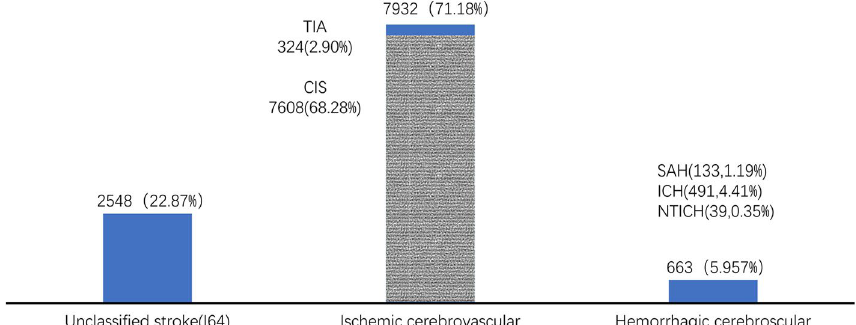
Figure 2. Types, numbers and ratio of CVD in hypertension